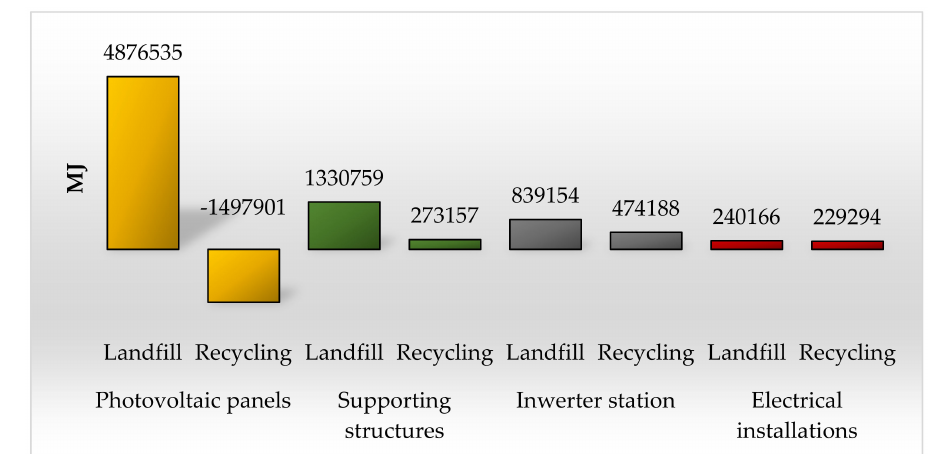
Figure 7. Results of the characterization of environmental consequences, in relation to cumulative energy demand (in MWh), occurring in the cycle of existence of selected groups of 1 megawatt photovoltaic power plant [unit: